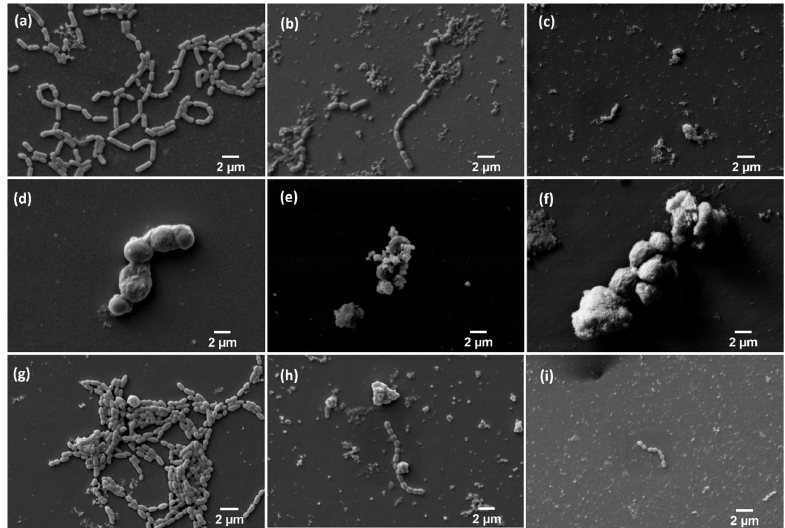
Figure 13. Scanning electron microscopy: ( a ) Growth control of Lactobacillus rhamnosus ; ( b ) Lactobacillus rhamnosus with nHAp; ( c ) Lactobacillus rhamnosus with Cu 2+ -doped nHAp; ( d ) Growth control of Candida albicans ; ( e ) Candida albicans with nHAp; ( f ) Candida albicans with Cu 2+ -doped nHAp; ( g ) Growth control of Streptococcus mutans ; ( h ) Streptococcus mutans with nHAp; ( i ) Streptococcus mutans with Cu 2+ -doped nHAp; Mag = 10,000×.